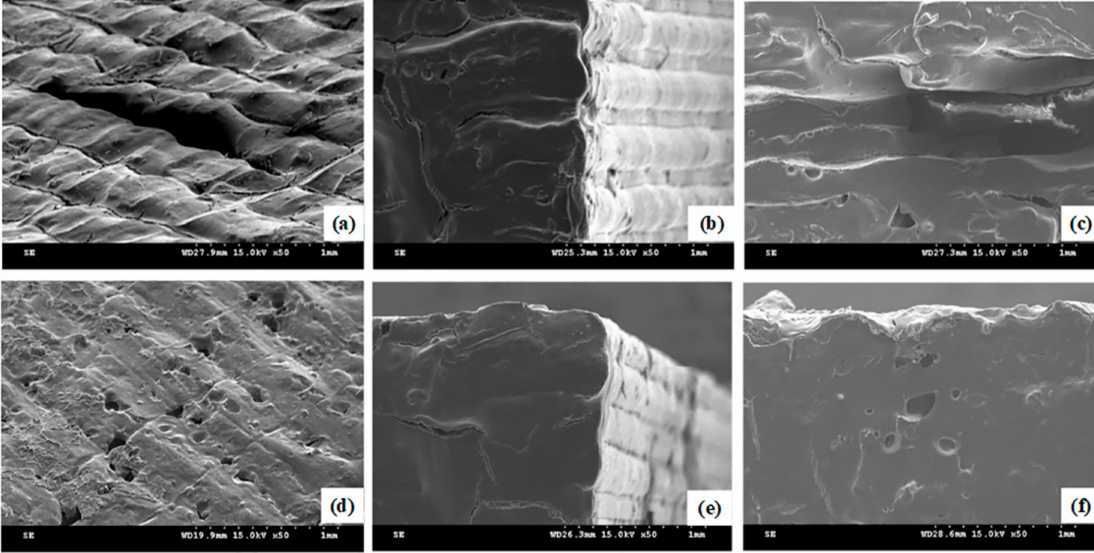
Figure 5. SEM images from different perspectives: ( a , d ) layer surface view; ( b , e ) isometric view; ( c , f ) facture section view; ( a , b , c ) the samples with the maximum tensile strength; ( d , e , f ) the samples with the minimum tensile